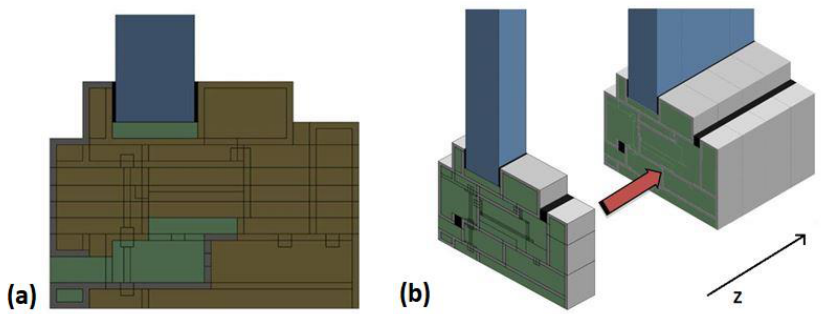
Figure 3. An individual 117-component generic frame cross-section ( a ) and 600 mm long sill section assembly ( b ) constructed from 30 individual cross-sections.